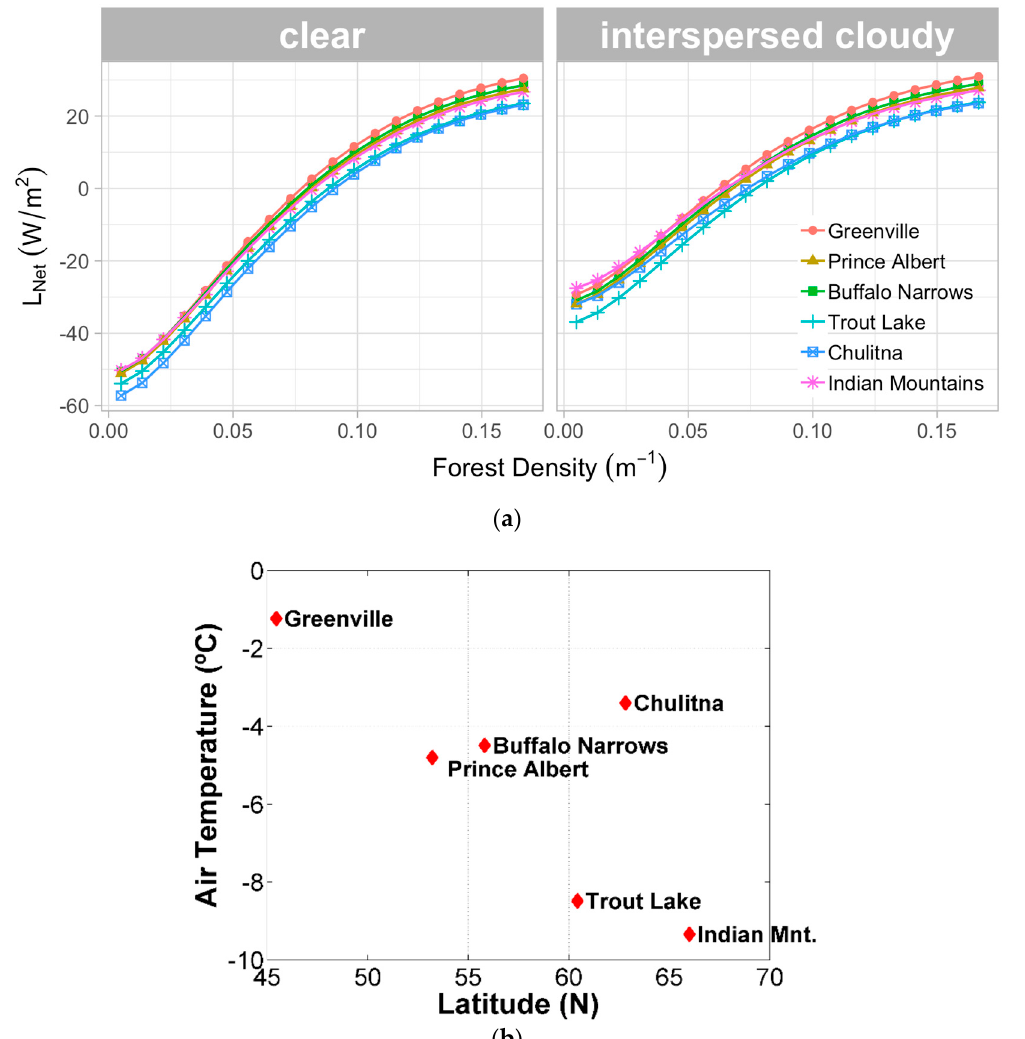
Figure 5. Variations of net longwave radiation on level forests with vegetation density at different sites under clear and interspersed cloudy sky conditions ( a ) and seasonal average air temperature. ( b ). Legend lists the sites in increasing order of latitude from top to bottom.